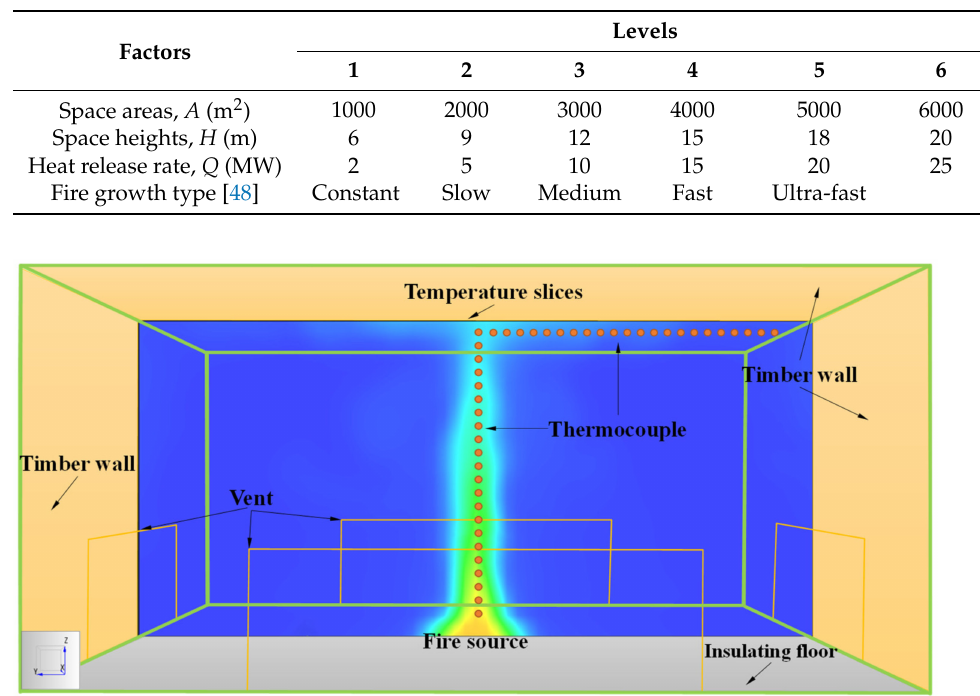
Table 1. Structural space size and fire source parameters.